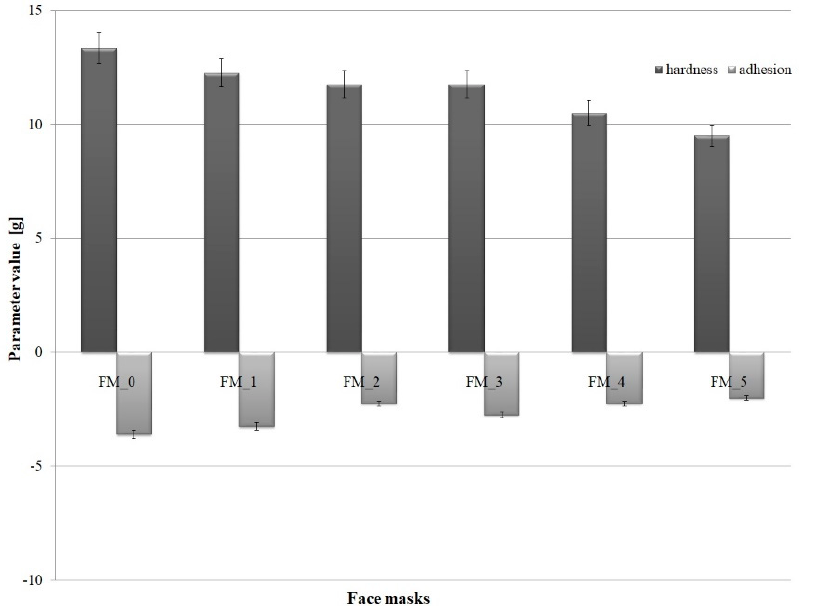
Figure 3. Hardness and adhesive force as a function of Lonicera caerulea Fruit Powder concentration in face masks.